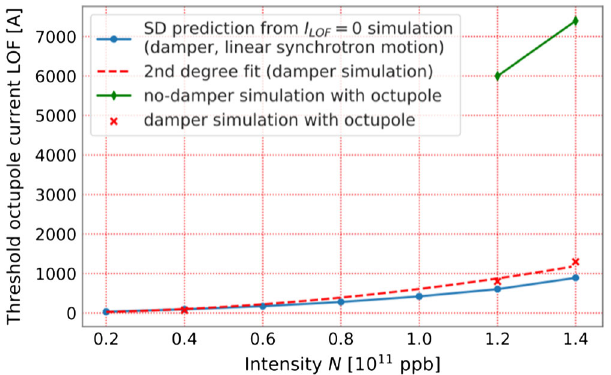
FIG. 9. Case of Fig. 8 analysed in detail through P y HEADTAIL tracking simulations (with Gaussian distributions), revealing a good agreement between the two approaches: (blue line) with the usual one-mode approach stability diagram (using the simulation results from P y HEADTAIL without Landau octupoles); (dotted red line) P y HEADTAIL simulations with both Landau octupoles and TD; (green line) P y HEADTAIL simulations with Landau octupoles but without TD. The TMCI intensity threshold without TD is at ∼ 0 . 8 × 10 11 ppb. This figure is courtesy of Oeftiger